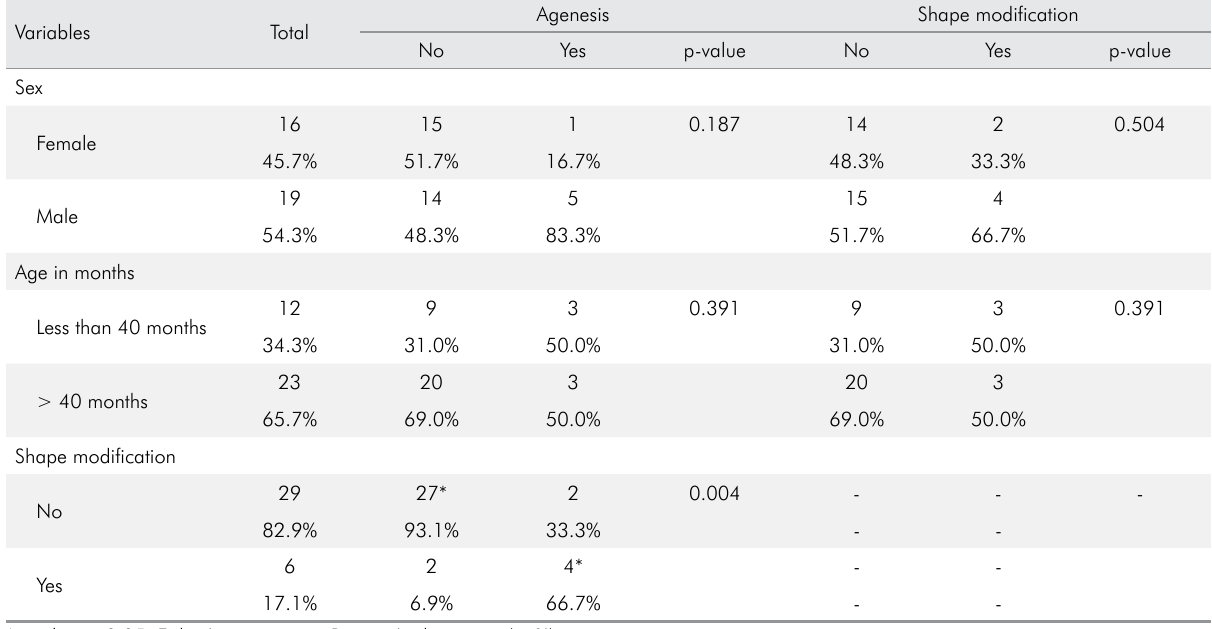
Table 2. Evaluation of the presence of agenesis and shape modifications in children with congenital Zika virus syndrome. Variables Total